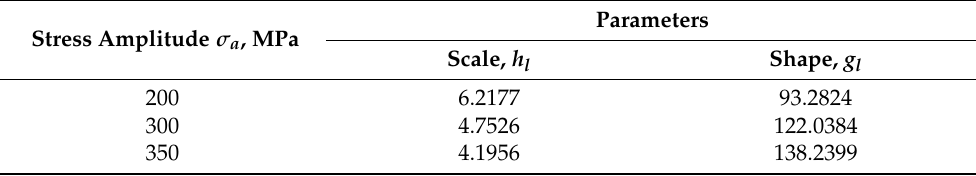
Table 2. Parameters of Weibull distribution for fatigue lives of 1.0570